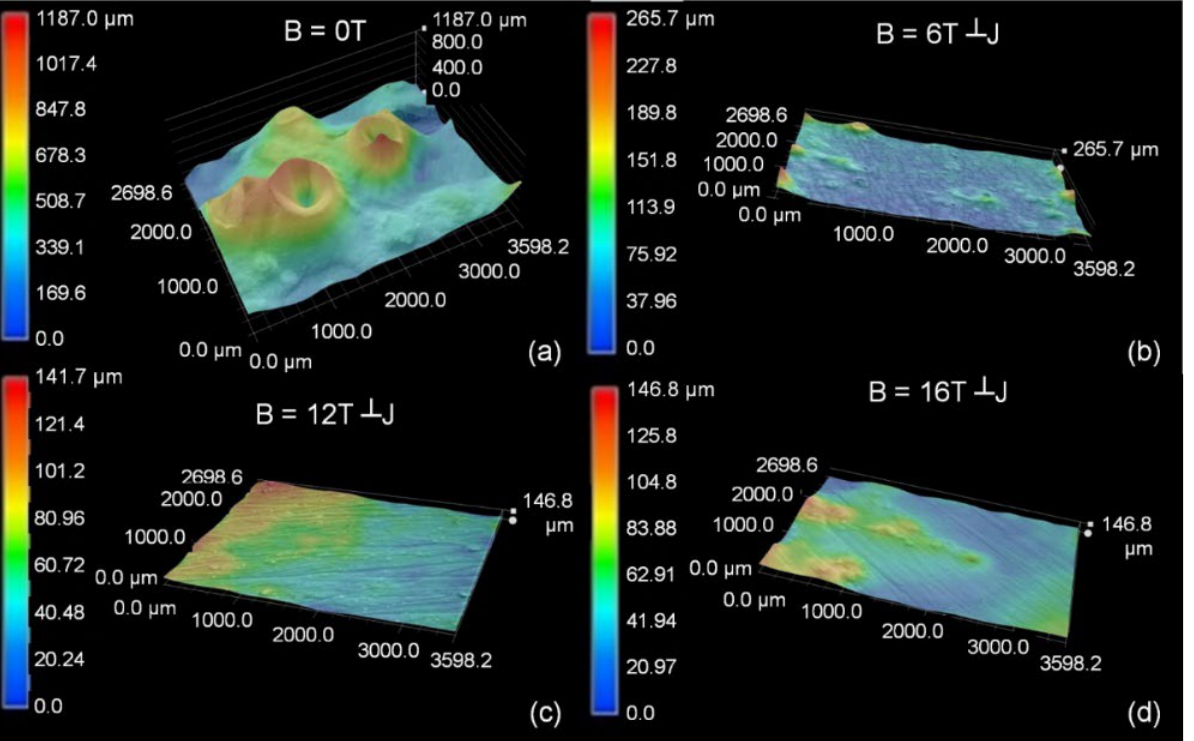
Figure 1. The schematic experimental apparatus.